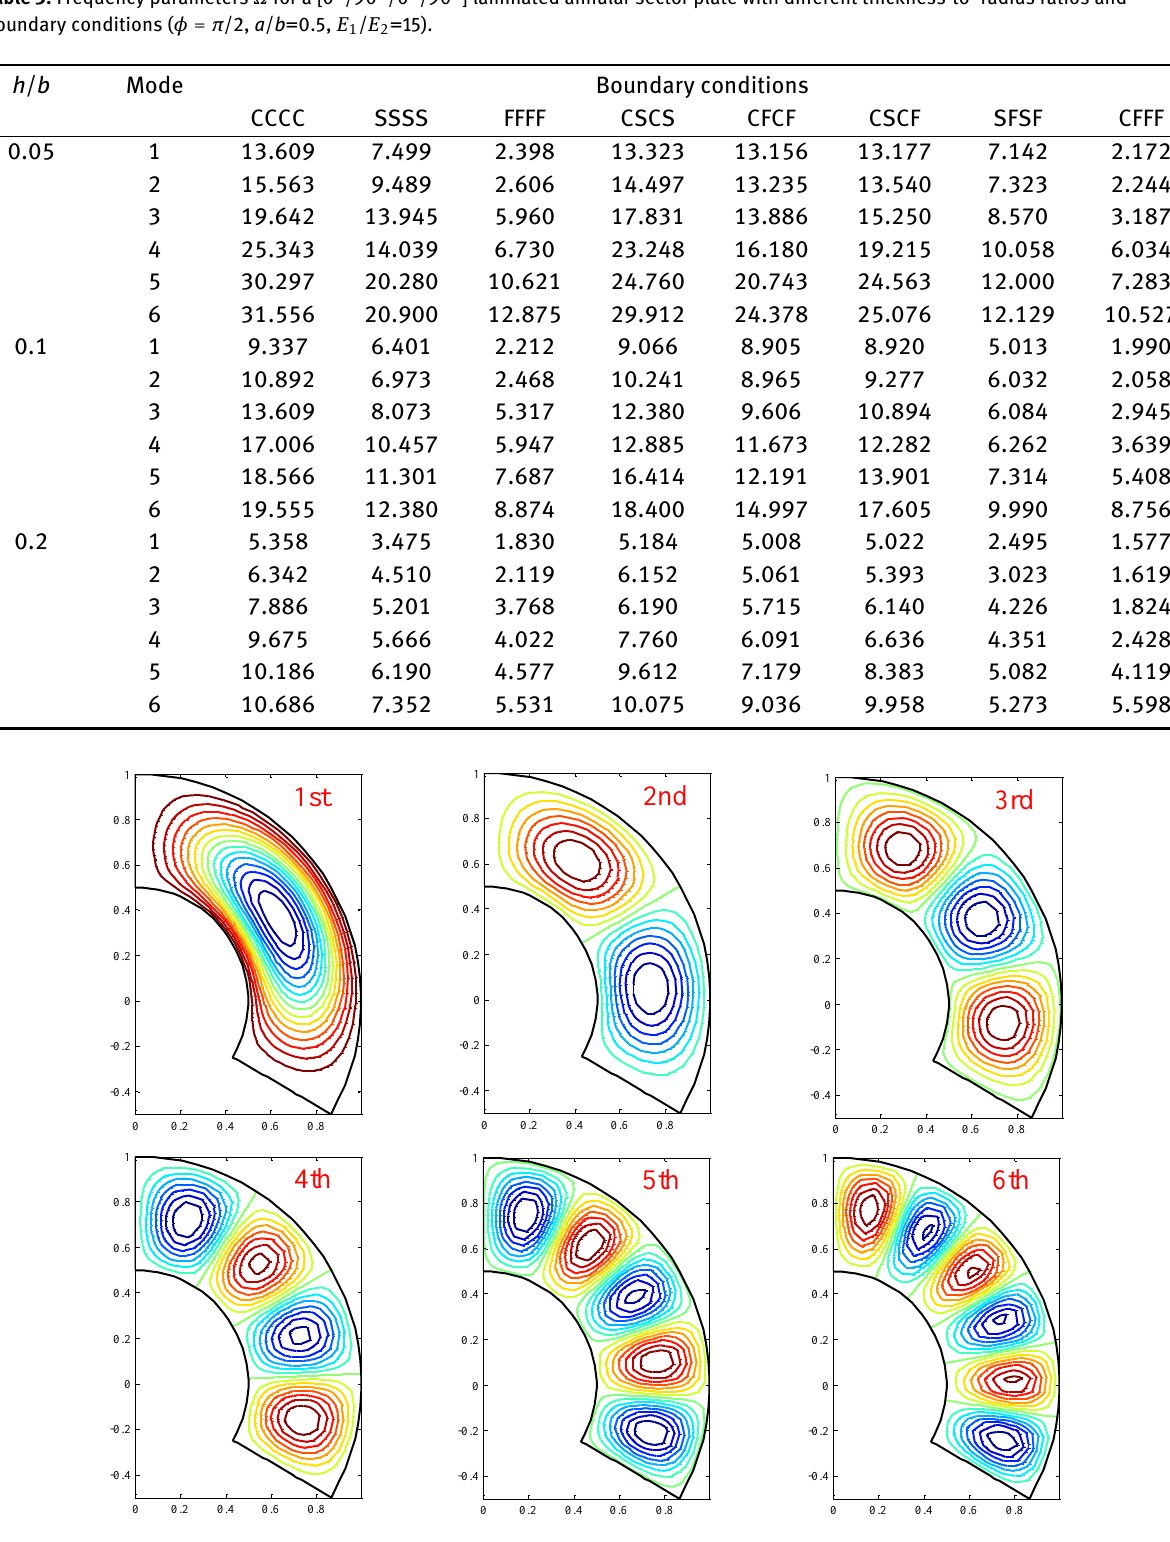
Table 3: Frequency parameters Ω for a [0 ∘ /90 ∘ /0 ∘ /90 ∘ ] laminated annular sector plate with different thickness-to- radius ratios and